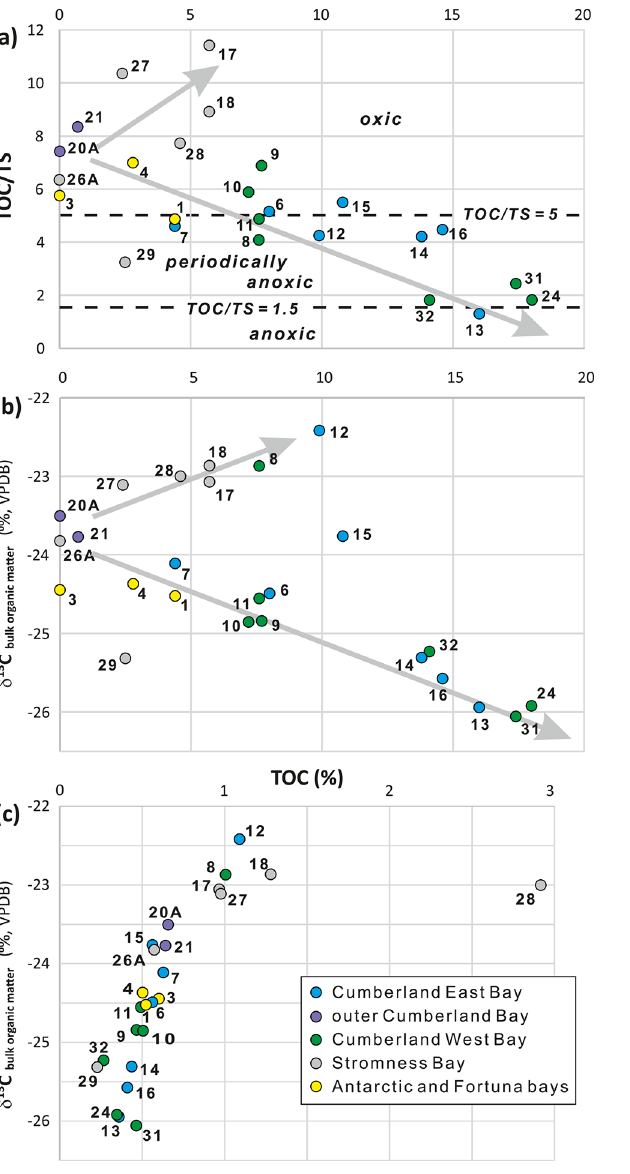
Figure 5. Total organic carbon to total sulfur ratio (TOC / TS) (a) , carbon stable isotopes of bulk organic matter in the sediments (b) in relation to distance from the fjord mouth, and the relation between TOC and the δ 13 C values (c) . Note the different trends/mixing lines in panel (a) , towards increasing TOC / TS ratios in Stromness Bay and towards lower ratios in Cumberland Bay, and in panel (b) , towards less negative δ 13 C values for Stromness Bay and coves and towards more negative values for the main basins of Cumber- land Bay affected by tidewater glaciers. Dashed TOC / TS lines in panel (a) are after Berner (1983). They demarcate TOC / TS ratios suggested for anoxic ( < 1.5), periodically anoxic (1.5–5), and oxic conditions (ratios > 5). Trends in panel (b) may represent the pro- gressive mixing of different types of bulk organic matter, namely (1) material typical of open-marine conditions ( δ 13 C ∼− 24‰), (2) likely petrogenic organic carbon supplied by glaciers ( δ 13 C ∼− 26‰), and (3) organic matter derived from fresh terrestrial and marine sources ( δ 13 C ∼−